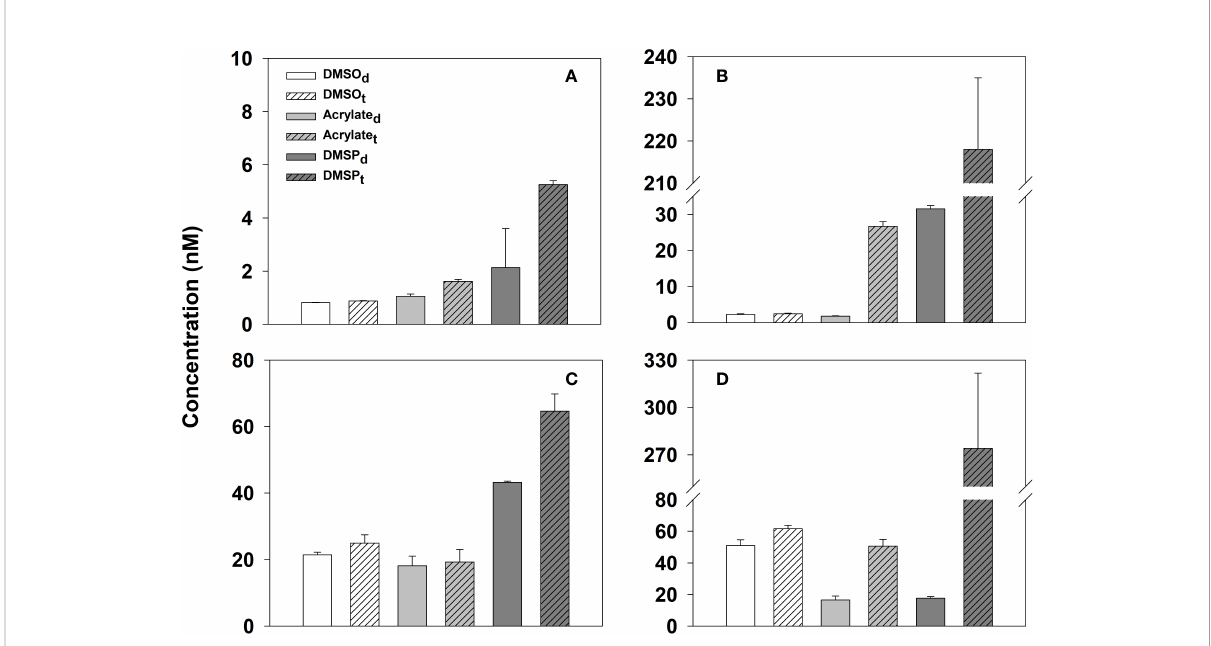
FIGURE 4 Dissolved and total concentrations of acrylate, DMSP and DMSO in samples collected at the CO site between April 15-18 in the vicinity of (A) Pocillopora sp., (B) a brown macroalgae, Turbinaria ornata , (C) A. pulchra , and (D) a decomposing seaweed raft. Error bars denote the standard deviation from the measurement of replicate samples. See Table S1 for the data used to generate this fi